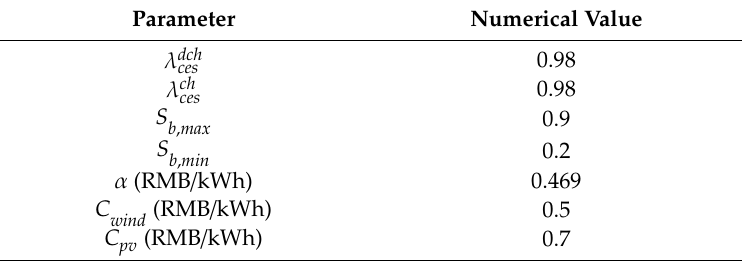
Table 4. Parameters of energy storage and power